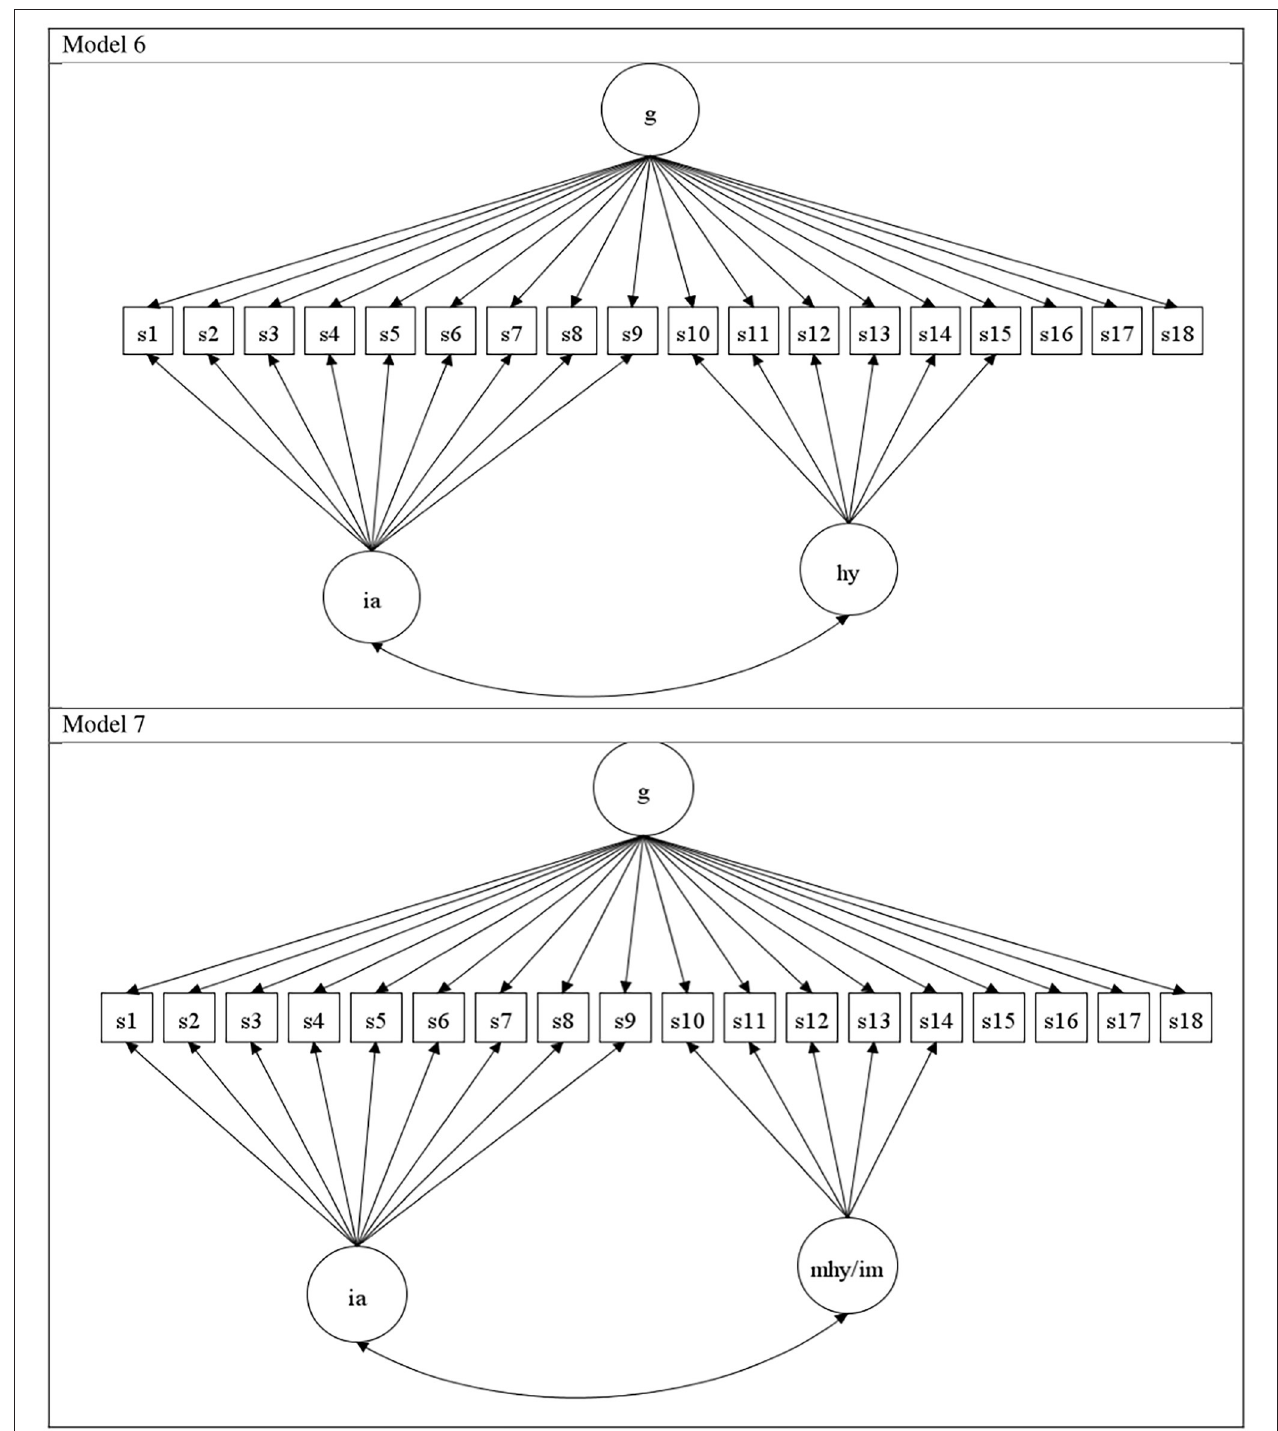
FIGURE 1 | Model 6: s – 1 bit factor, with IM as reference indicators g-factor: & IA and HY as specific factors. Model 7: s – 1 bit factor, with VHY/IM as reference indicators g-factor: & IA and MHY/IMP as specific factors. ia, inattention symptoms; hy, hyperactivity; im, impulsivity; g, general factor ADHD; mhi, motor hyperactivity/impulsivity; vhi, verbal hyperactivity/impulsivity. S1 to s18 refers to the eighteen ADHD symptoms, in the order listed in DSM-IV and Supplementary Table 1 .